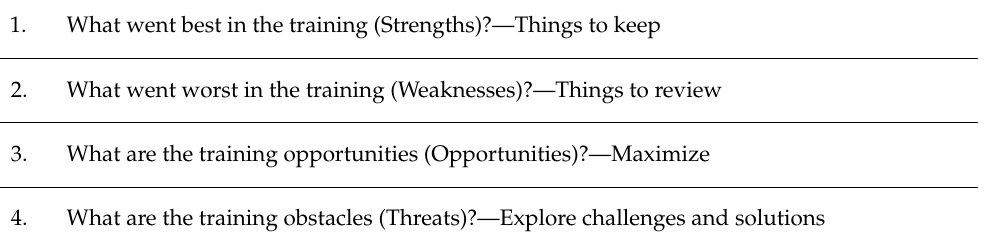
Table 1. Questions included in the